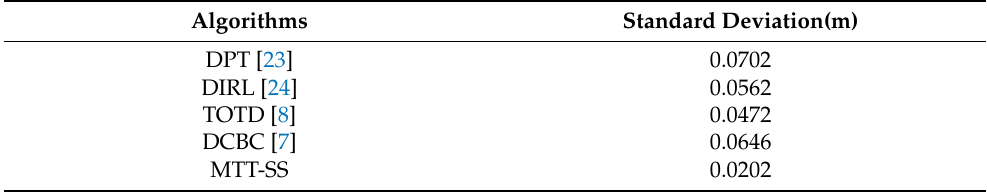
Table 2. Standard deviation of localization errors.